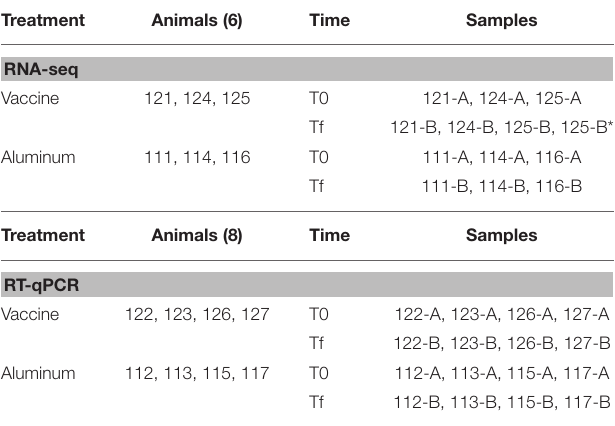
TABLE 1 | Samples used in RNA-seq and RT-qPCR study.